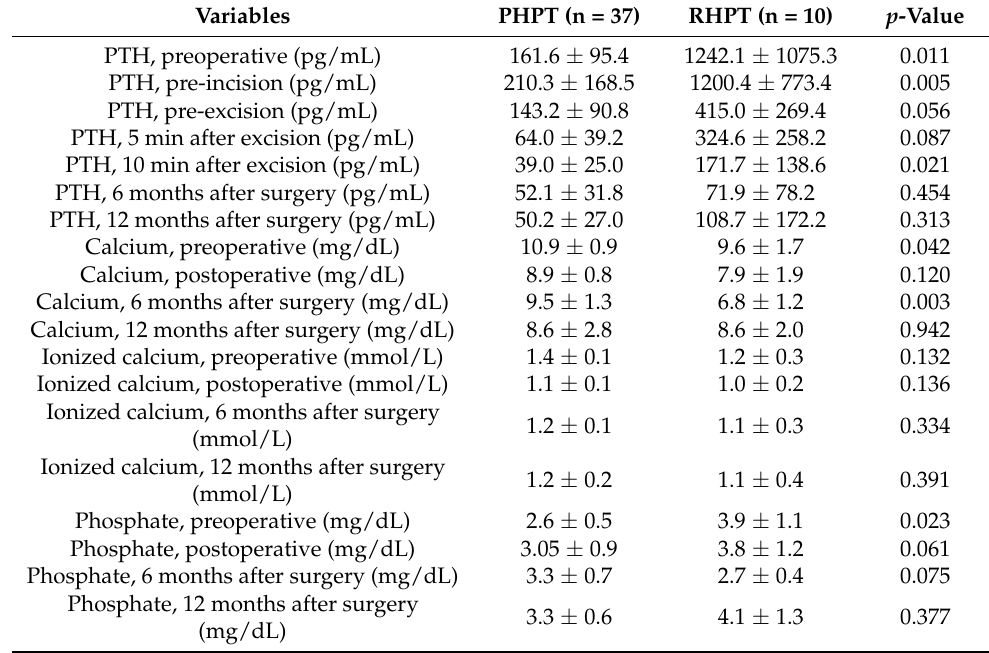
Table 3. Laboratory findings according to primary and renal (secondary and tertiary) hyperparathy-